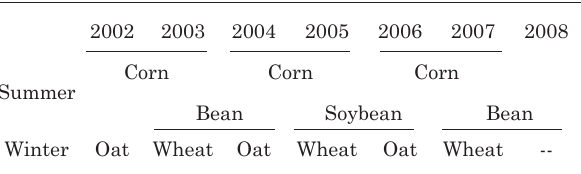
table 2. crop rotation from 2002 to 2008 in the experimental